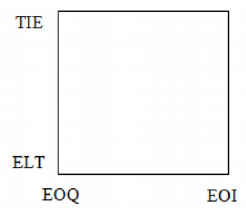
Figure 5. Factorial plan: Bullwhip